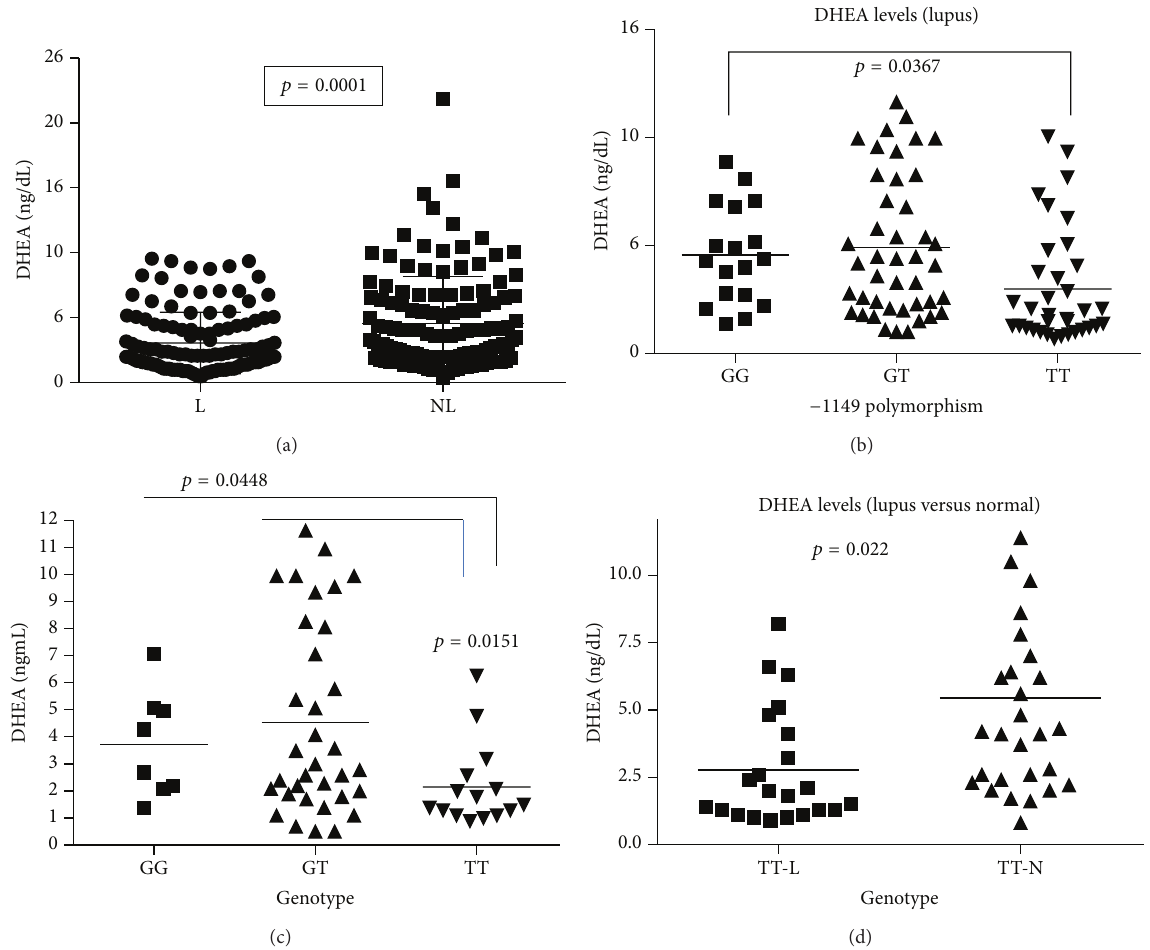
Figure 5: Serum levels of DHEA. (a) shows that lupus patients had a significant lower level of serum DHEA ( 𝑝 = 0.0001 ). (b) shows that the TT genotype had the lowest level of DHEA compared to GT or GG in lupus patients. Furthermore, (c) demonstrates that African American women with lupus and the TT genotype had the lowest level of DHEA. (d) shows that the serum DHEA level in TT genotype in African American women was significantly lower when compared to their normal age-matched nonlupus patients ( 𝑝 = 0.022 ).